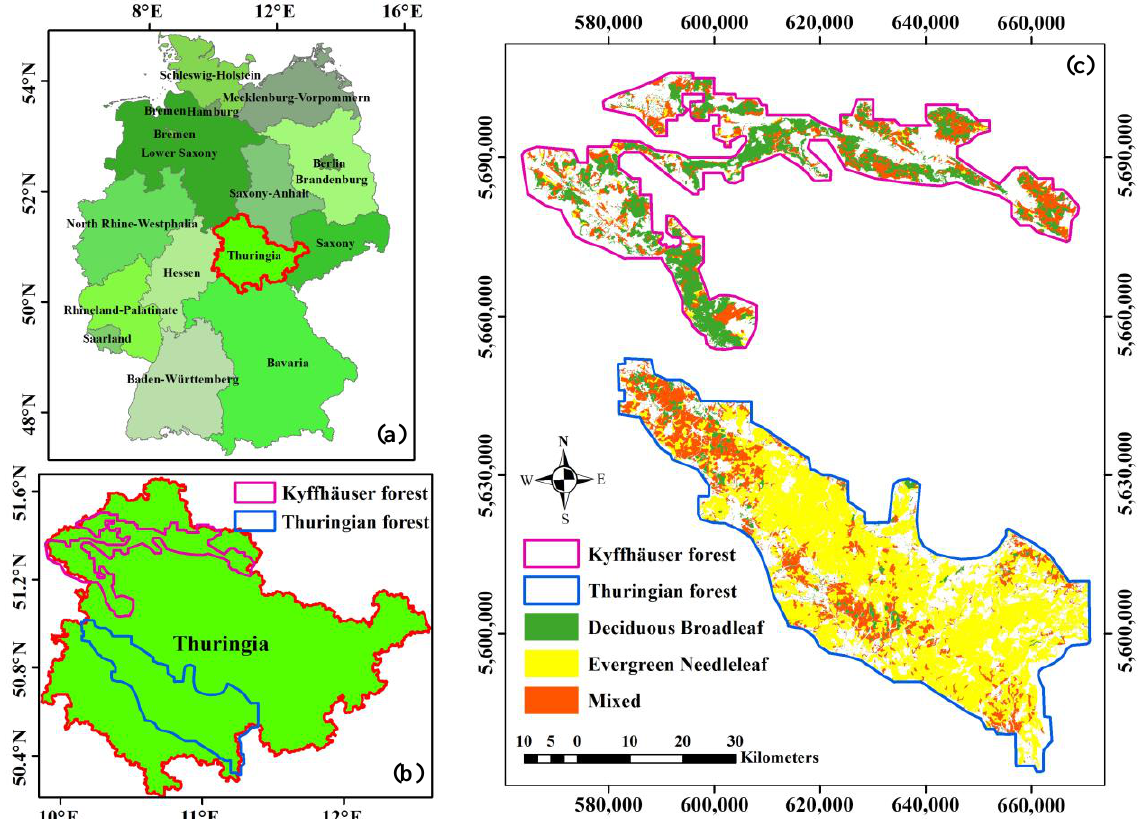
Figure 1. Study areas. ( a ) location of the Thuringia state in Germany (the state with red border), ( b ) location of the Kyffhäuser forest (pink) and Thuringian forest (blue) in Thuringia; ( c ) Forest type map (WGS84/UTM zone 32N) over study sites available at geoportal-th.de (accessed on 2 September 2022) [36]. Since only forest type map has been downloaded and used, the white spaces show other land covers.